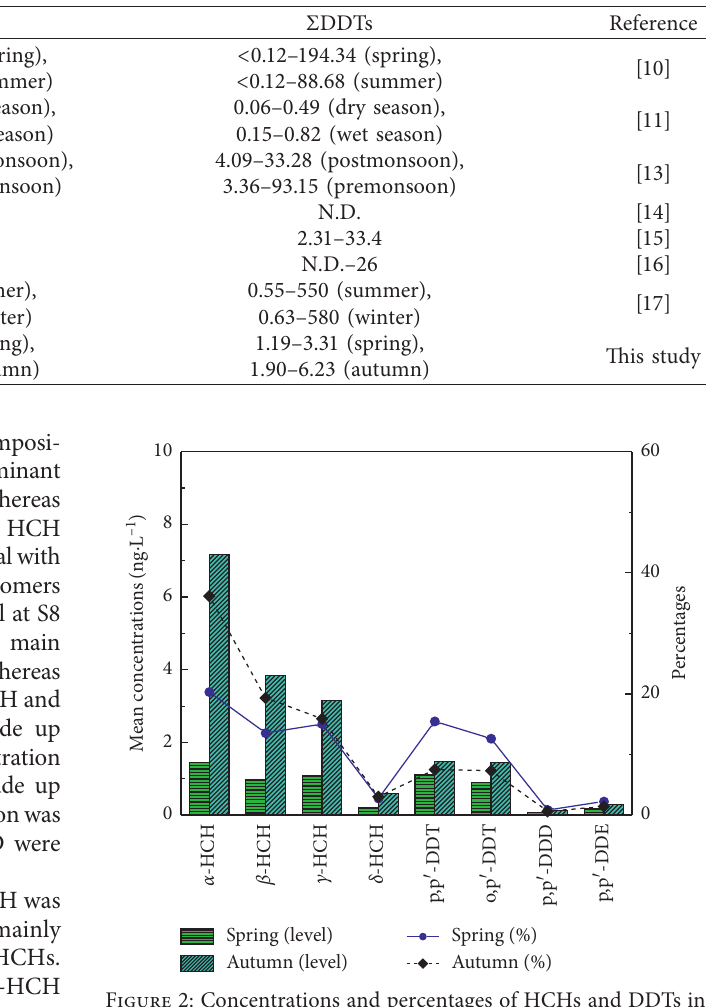
Table 2: Comparison of Σ HCHs and Σ DDTs in surface waters (ng · L − 1 ).